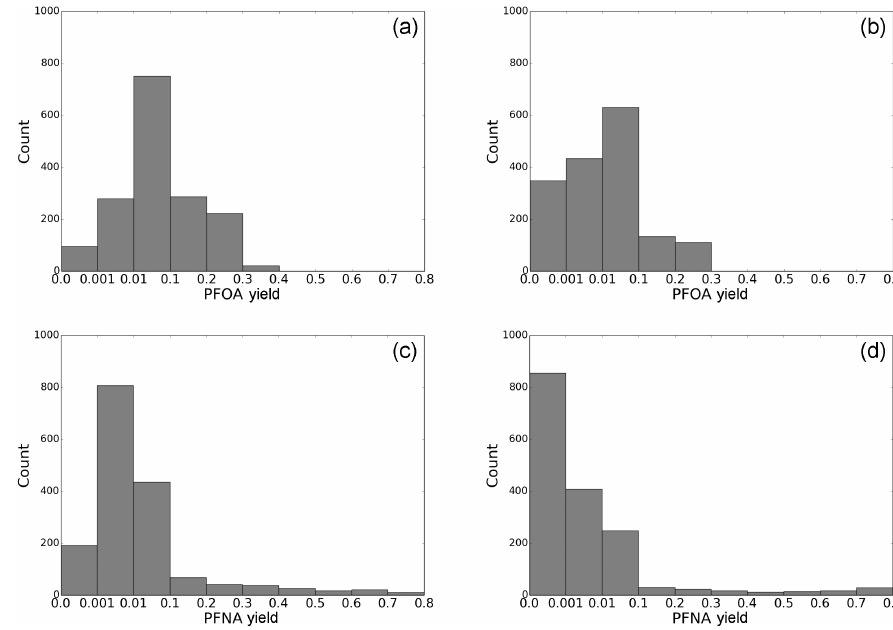
Figure 2. Histograms of variability in PFOA (a, b) and PFNA (c, d) theoretical maximum yields for both summer (a, c) and winter (b, d) conditions. Each count corresponds to a GEOS-Chem grid box’s output photochemical environment.